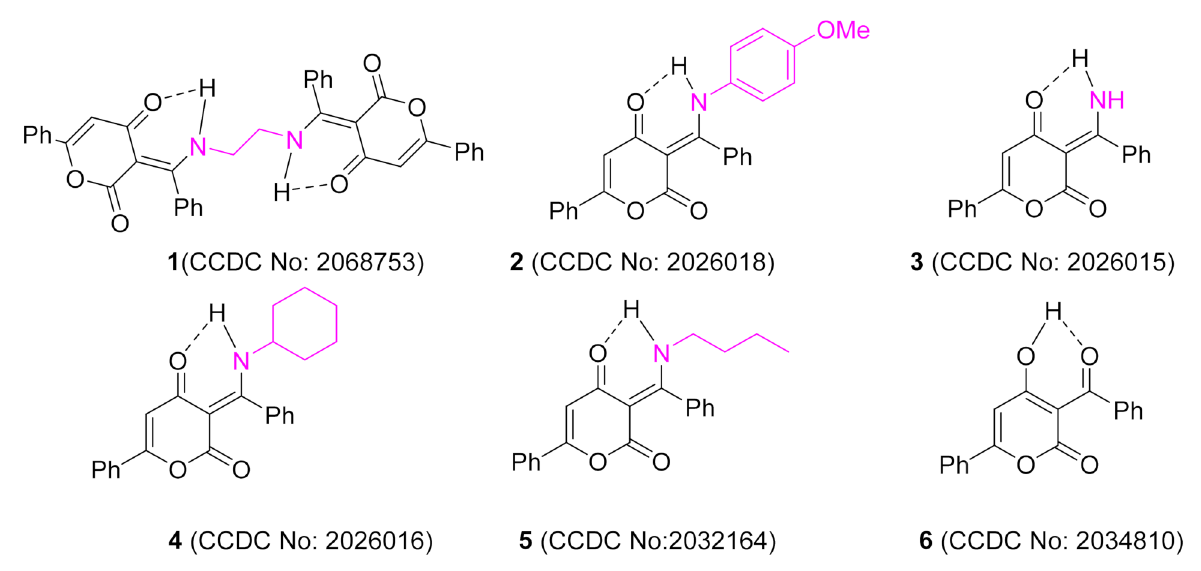
Figure 1. The structure of pyran-2,4-dione 1–6 employed in this